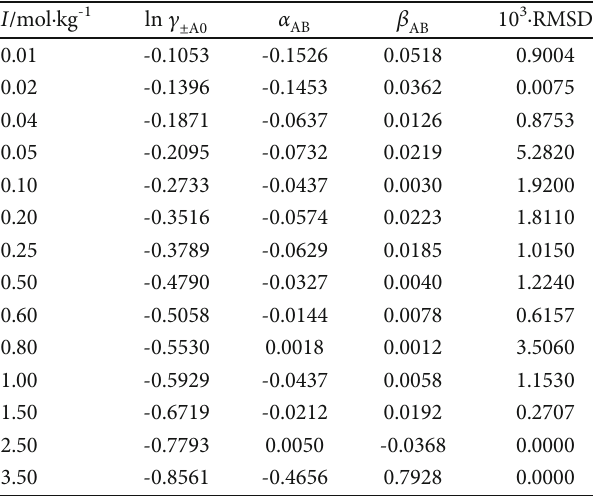
Table 5: The parameter values of Harned equation a